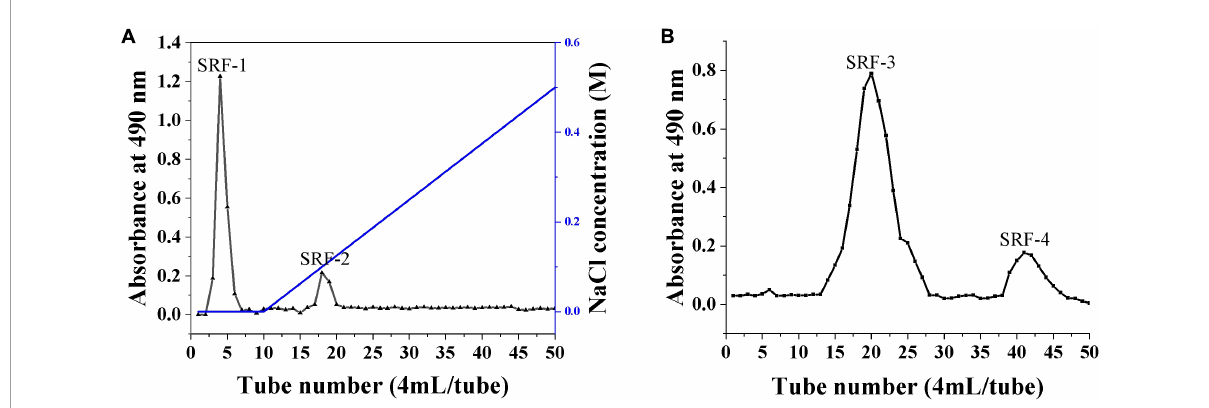
FIGURE1 Isolation and purification of polysaccharides from S. rugosoannulata by gel column. (A) DEAE cellulose column for the separation of crude polysaccharides. (B) SRF-1 was further separated by a Sephacryl S-200 high-resolution